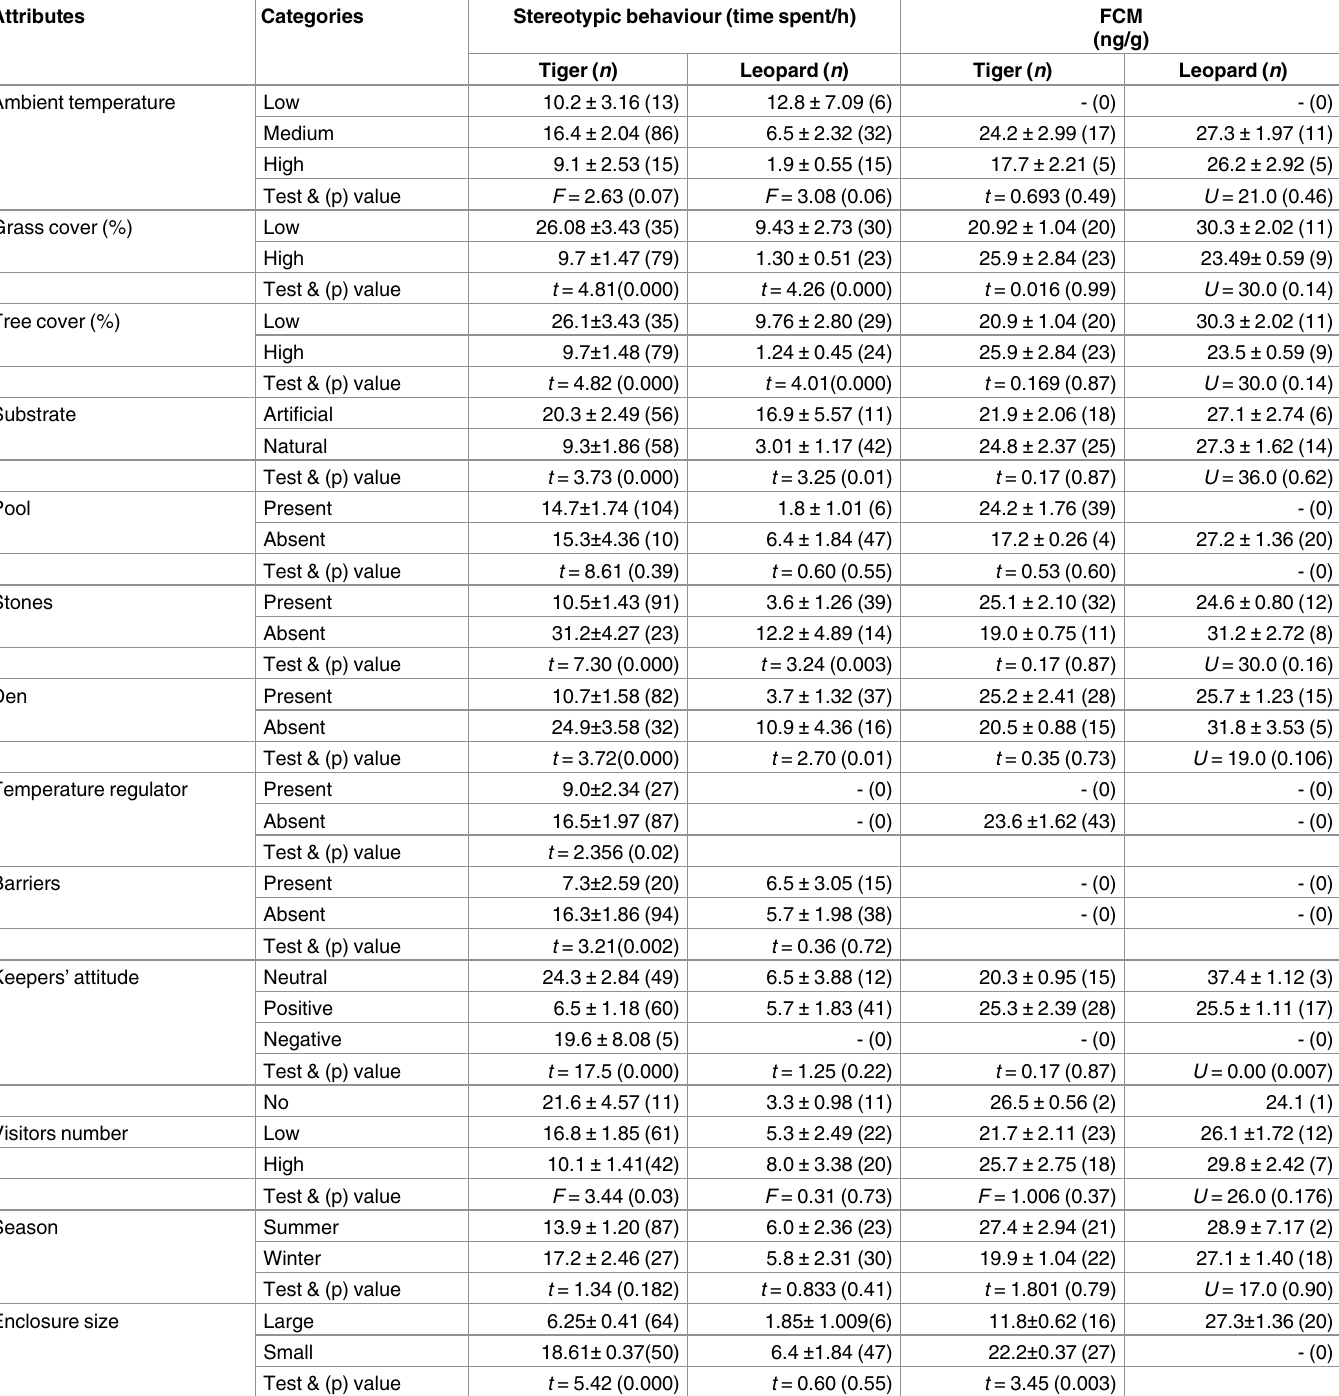
Table 3. Extent of stereotypic behaviour and FCM (with ± S.E) in relation to environmental factors in tigers ( n = 41) and leopards ( n = 21). Note: F indicatesUnivariateAnalysis of Variance; t indicatesindependent-samples T test, and U indicates Mann-Whitney U-test.